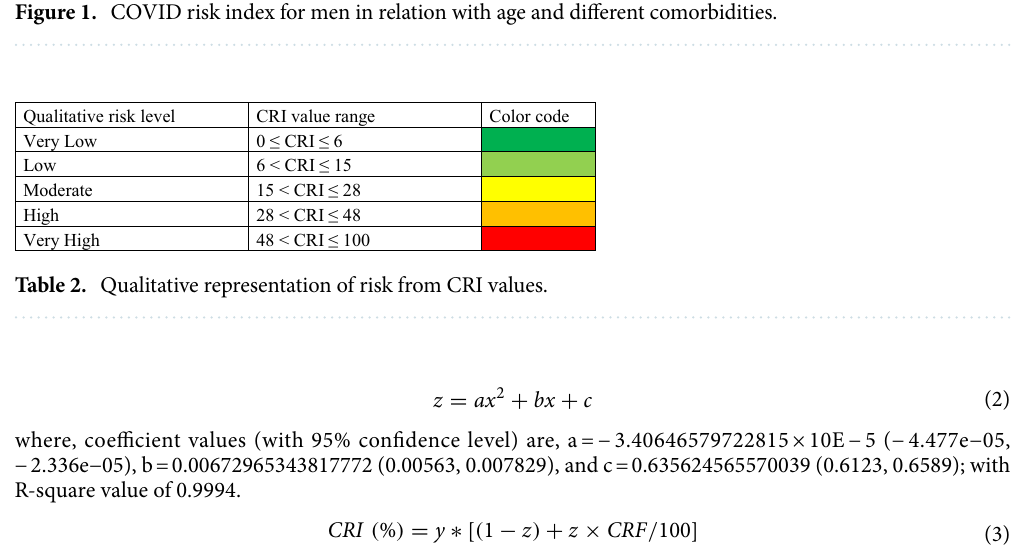
Figure 1. COVID risk index for men in relation with age and different comorbidities.